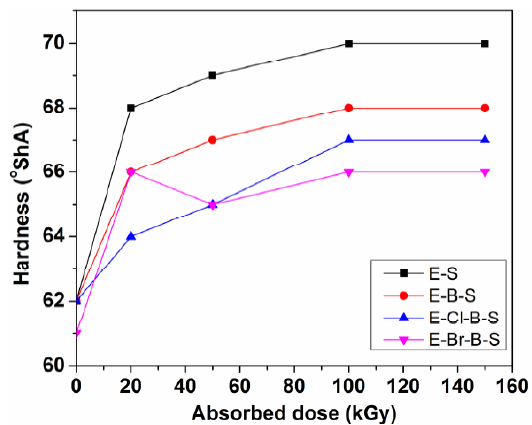
Figure 1. Variation of the hardness of EPDM composites regarding to the irradiation dose.